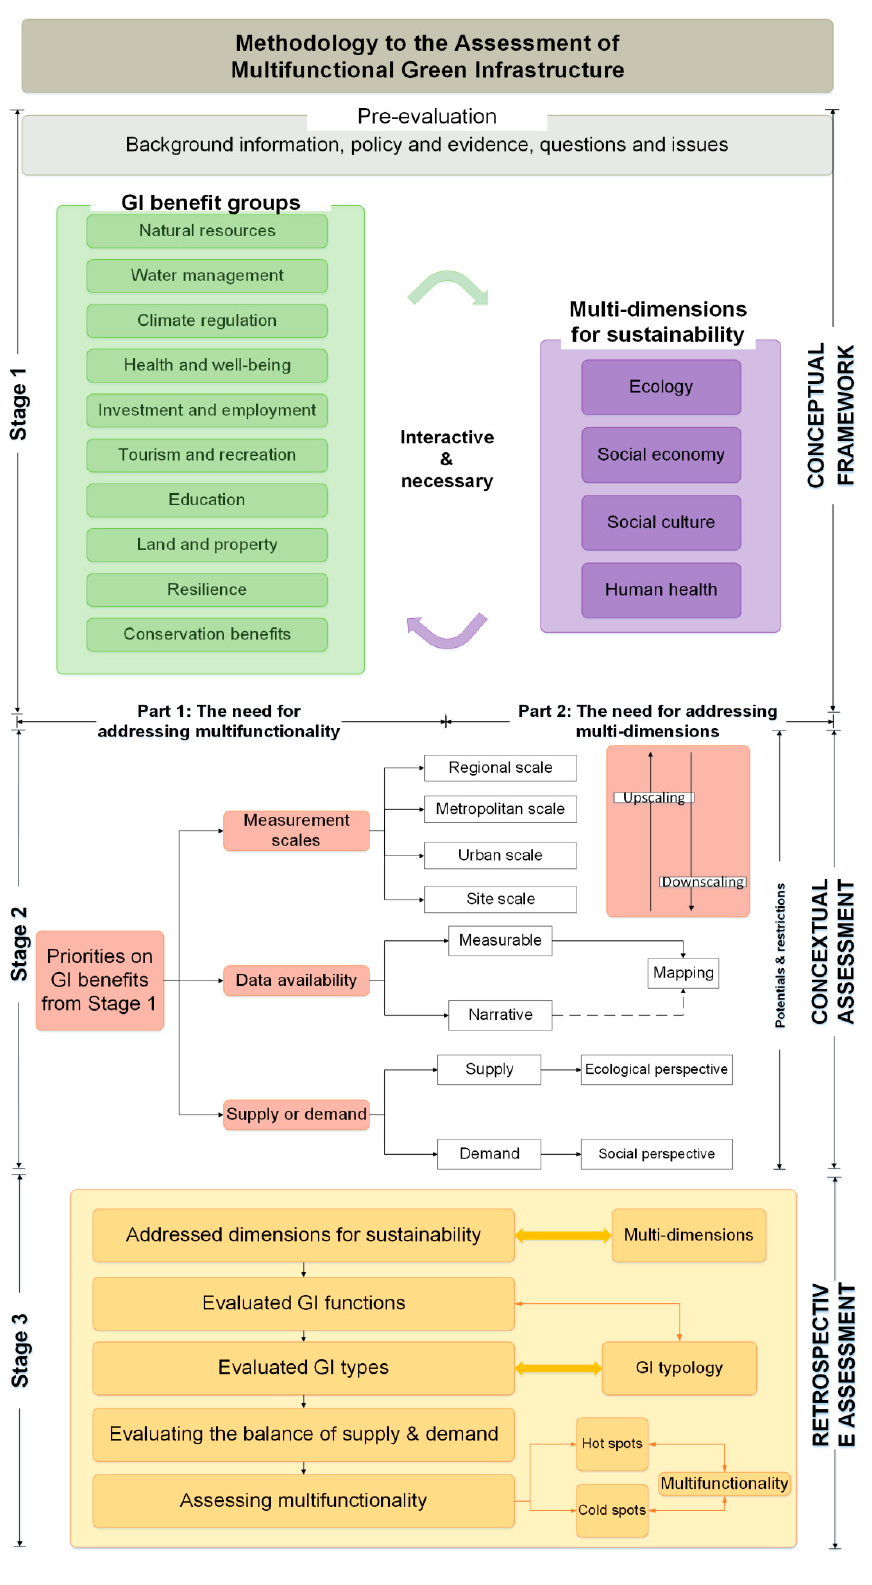
Figure 2. Flowchart on using the integrated indicator framework to conduct an AMGI.